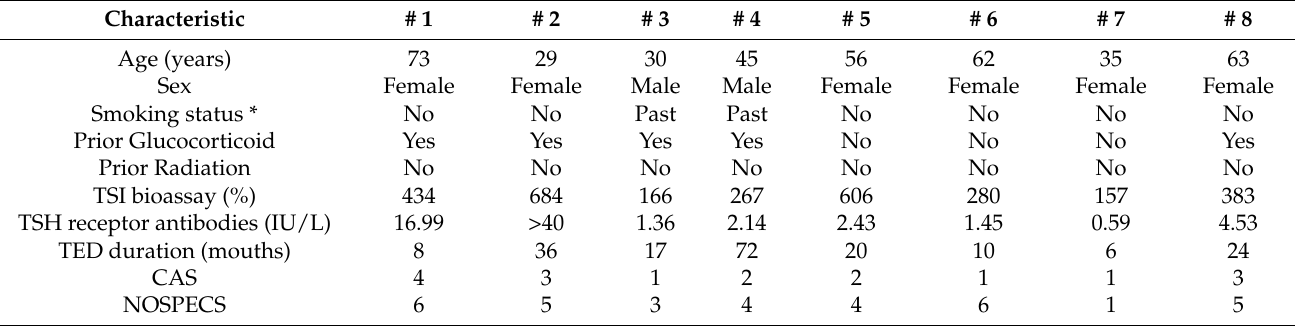
CAS—clinical activity score; NOSPECS—no signs or symptoms, only signs, soft tissue, proptosis, extraocular muscle, cornea, sight loss; TSH—thyroid-stimulating hormone; TSI—thyroid-stimulating immunoglobulin; TED—thyroid eye disease; * Smoking status: “no” means never-smoked; “past” means